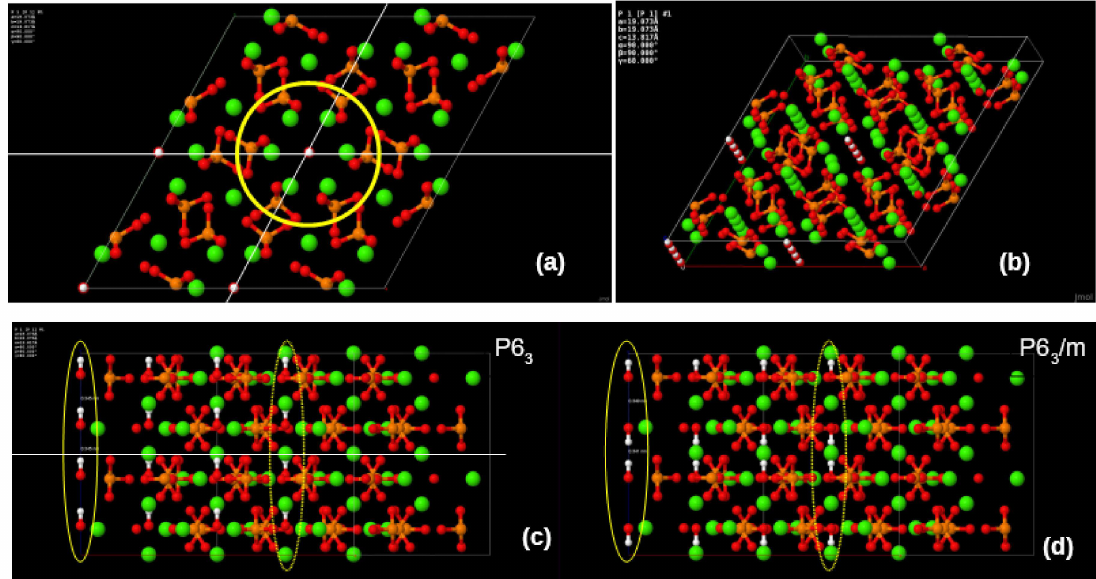
Figure 3. Images of supercell models with 2 × 2 × 2 = 8 unit cell of HAP (visualization using Jmol after DFT calculations: ( a ) top view—along the c axis of the OH channel (a yellow circle highlights the main central part around one OH channel); ( b ) supercell model in isometric projection; ( c ) HAP supercell model in lateral projection for the P6 3 phase (OH groups are parallel oriented (ordered) in OH channel along c axis and therefore can create a summarily polar state); ( d ) HAP supercell model in lateral projection for the P6 3 /m phase (OH groups are anti-parallel oriented (disordered) in OH channel along c axis and therefore can create a summarily non-polar